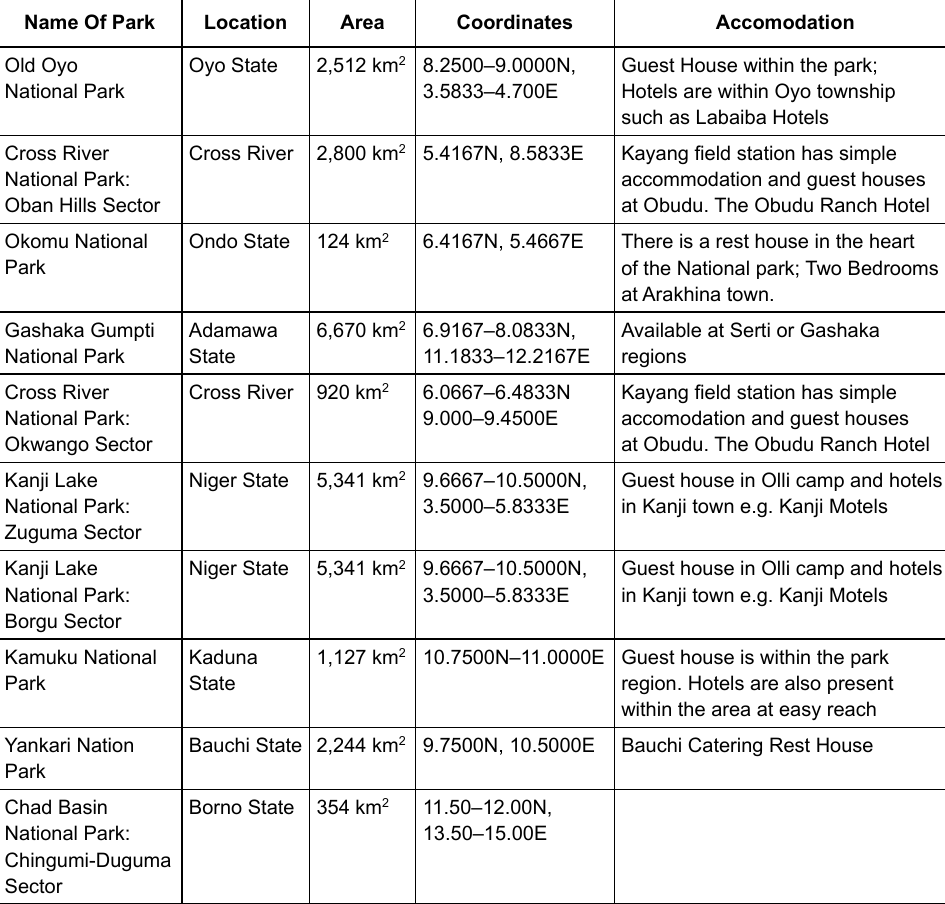
Table 1. National wildlife parks in